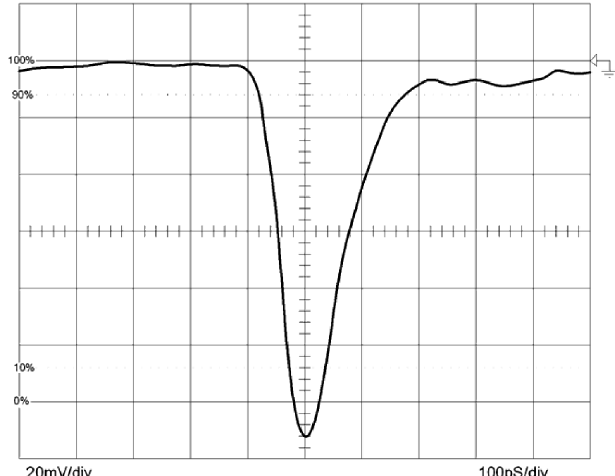
FIG. 3. Detector-limited photodiode signal of gain-switched seed laser at 1560 nm and 499 MHz pulse repetition rate. Similar photodiode signals were observed downstream of the fiber amplifier and PPLN frequency-doubler crystal; actual pulse width is narrower, as described in